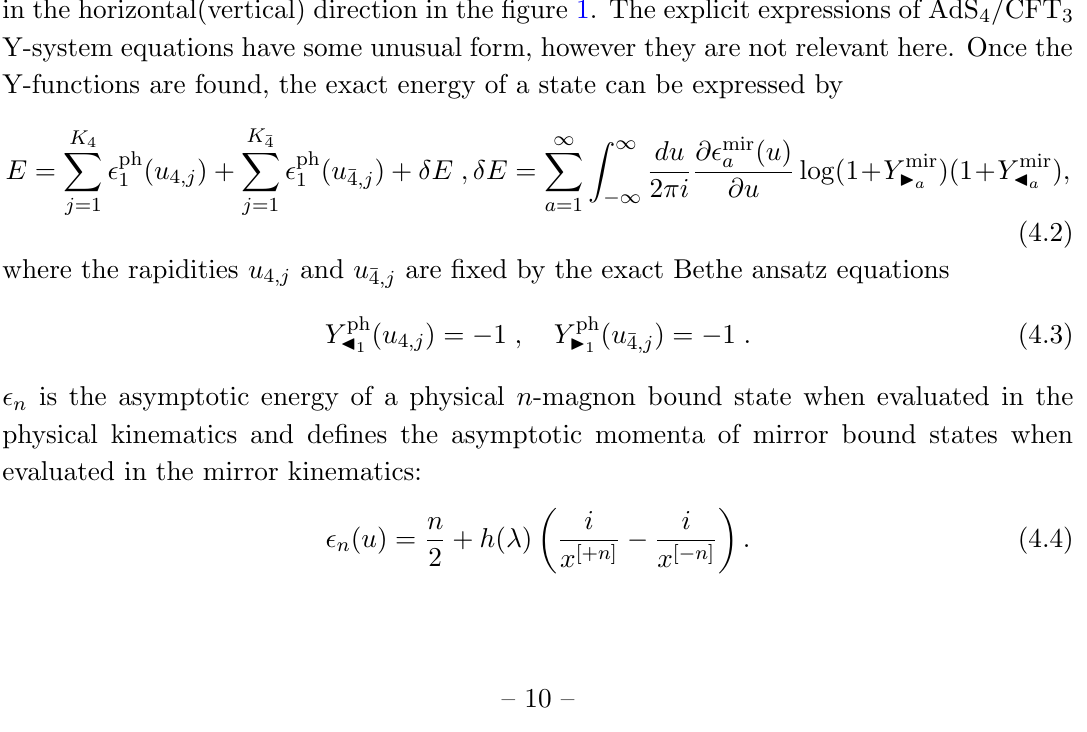
Figure 1 . The AdS 4 = CFT 3 Y-system. As shown in the (cid:12)gure, we have considered the most generic case when the two black node Y-functions are not equal to each other. We denote them as Y I Y J in the main a